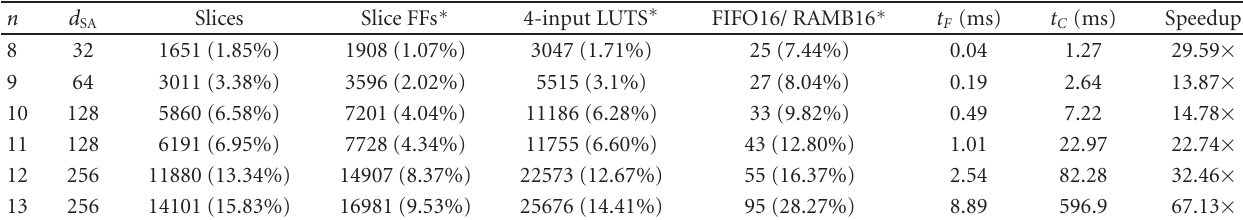
Table 5: Experimental results for stage 1.